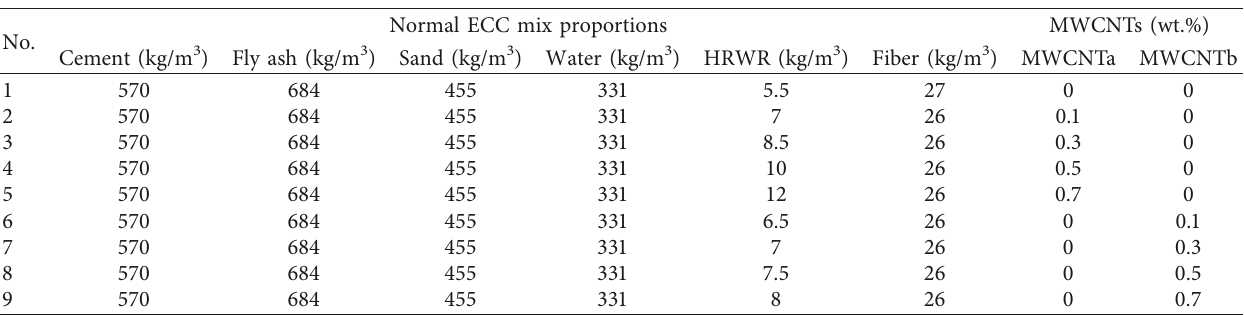
Table 3: Mix proportions of MWCNT-reinforced